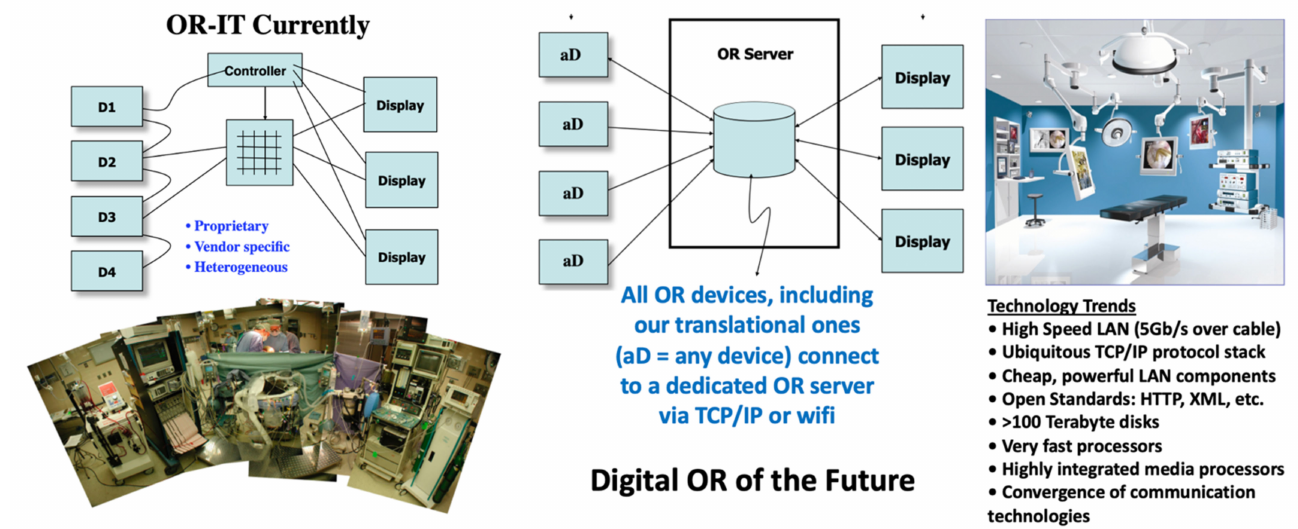
Figure 27. Current ( left ) OR vs. our proposed Digital OR of the Future ( right ) (Nowatzyk, A.G and Farkas,